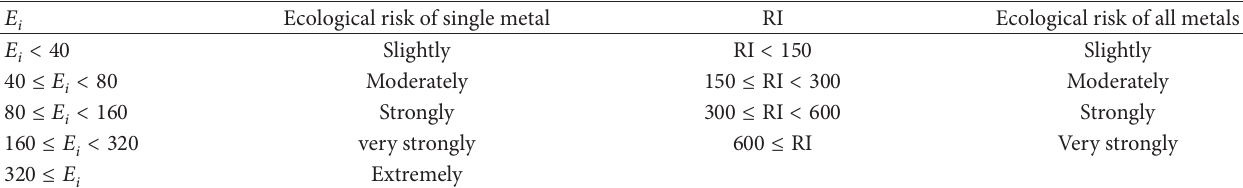
Table 2: Description of potential ecological risk degree.